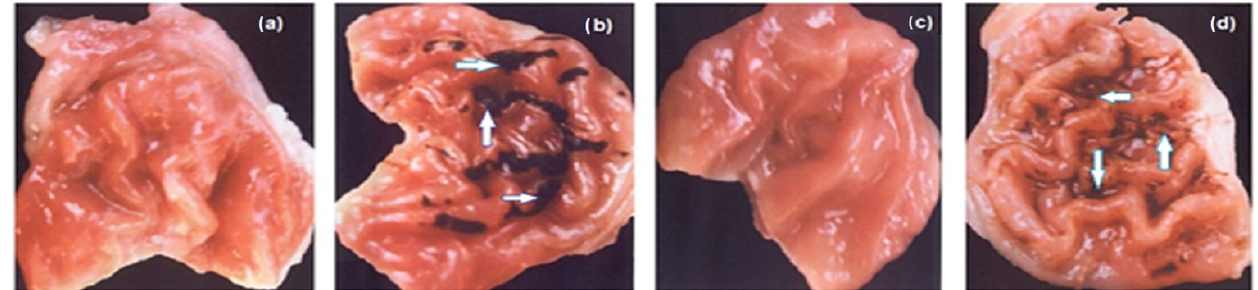
Figure 10. Gastrotoxic effects on the administration of ( a ) 0.5% CMC (control); ( b ) S -naproxen-treated group; ( c ) equimolar MAS-1696-treated group; ( d ) molar equivalent of S -naproxen + 4-allyl guaiacol physical mixture. Arrows indicate ulceration and lesions.